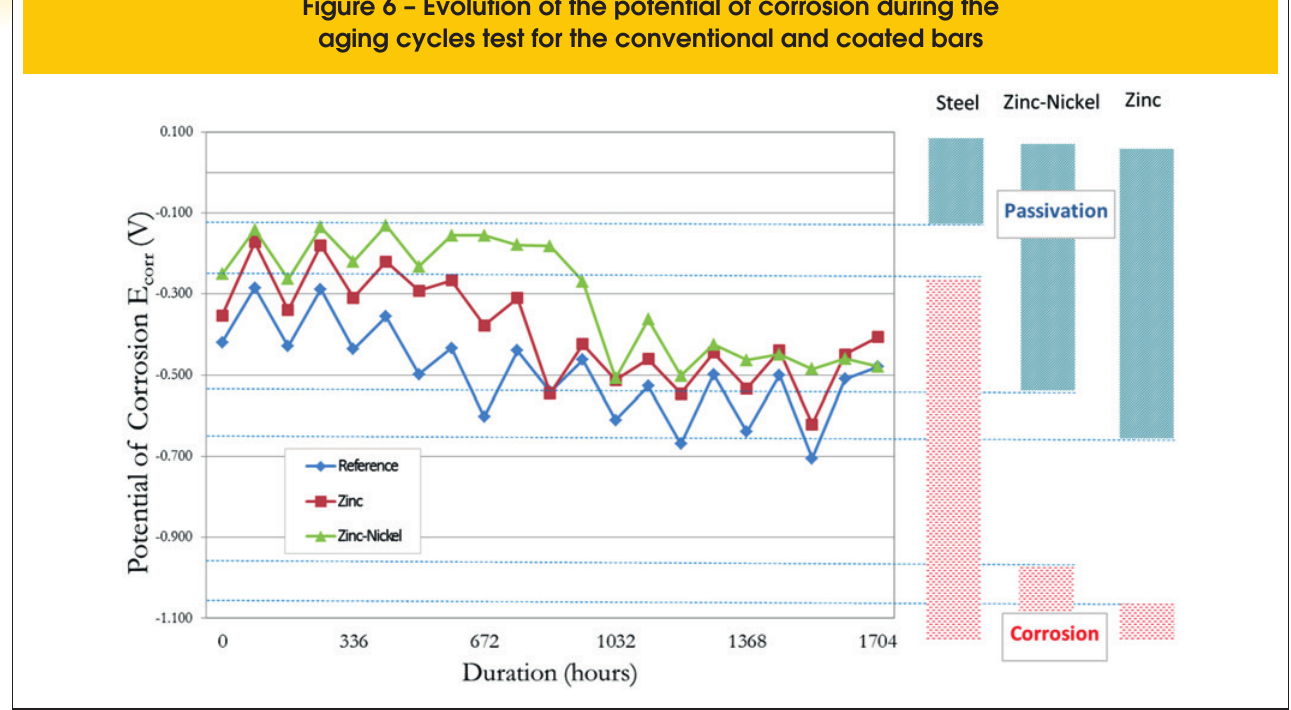
Figure 6 – Evolution of the potential of corrosion during the aging cycles test for the conventional and coated bars